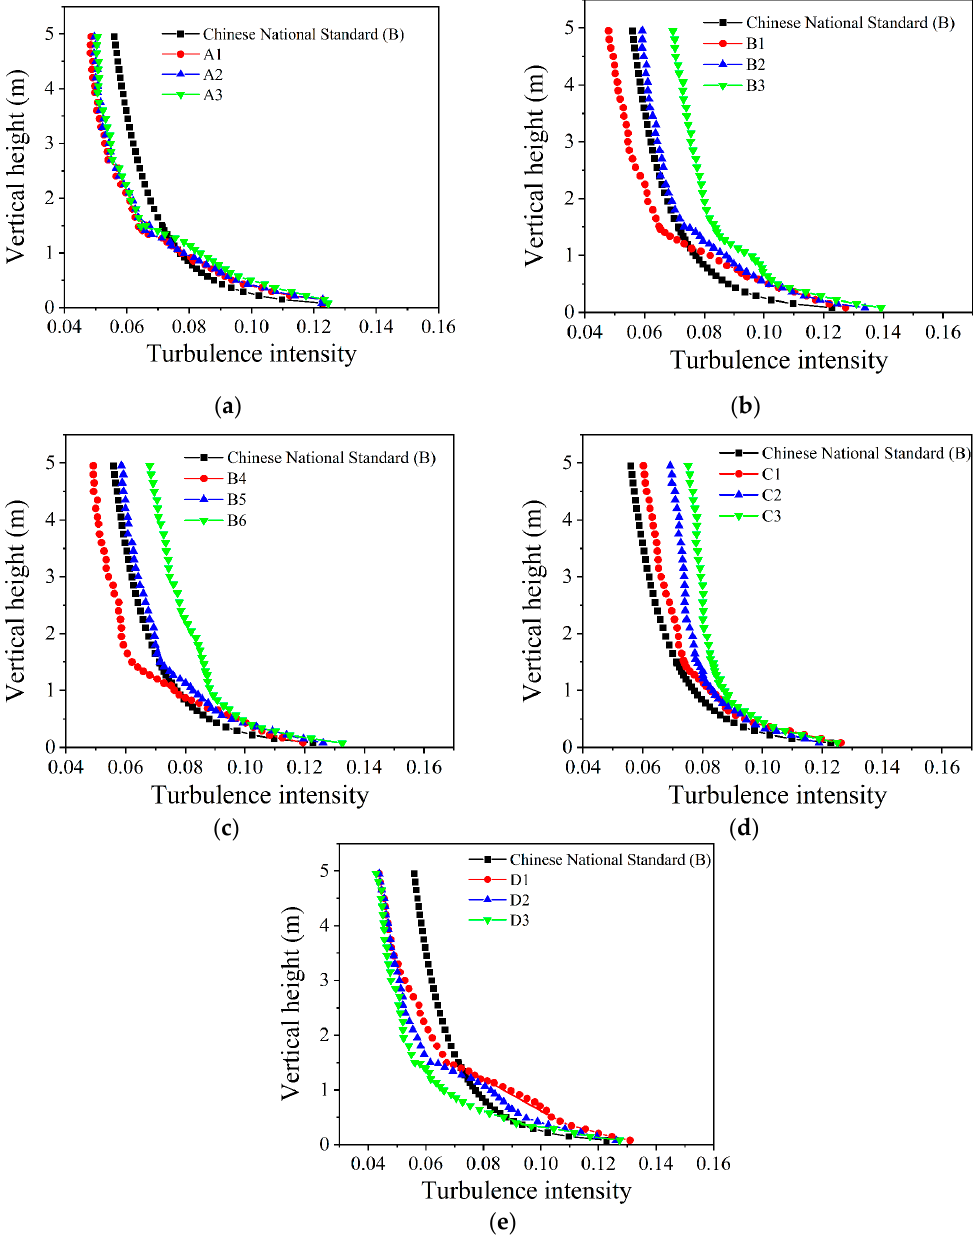
Figure 7. Influences of random number parameters on turbulence intensity: ( a ) Normal distribution range; ( b ) Standard deviation (without roughness elements); ( c ) Standard deviation (with roughness elements); ( d ) Assignment direction; ( e ) Assignment height.